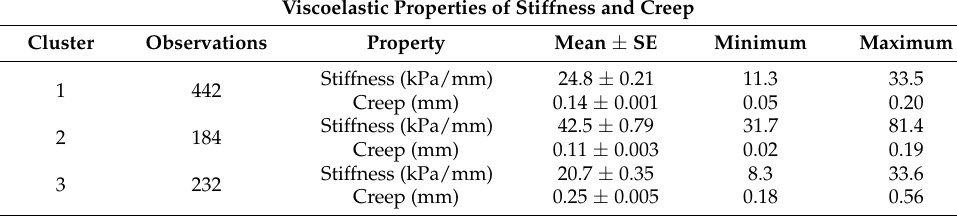
Table 4. Subject population clusters representing viscoelasticity and stretchability of facial skin with facial locations